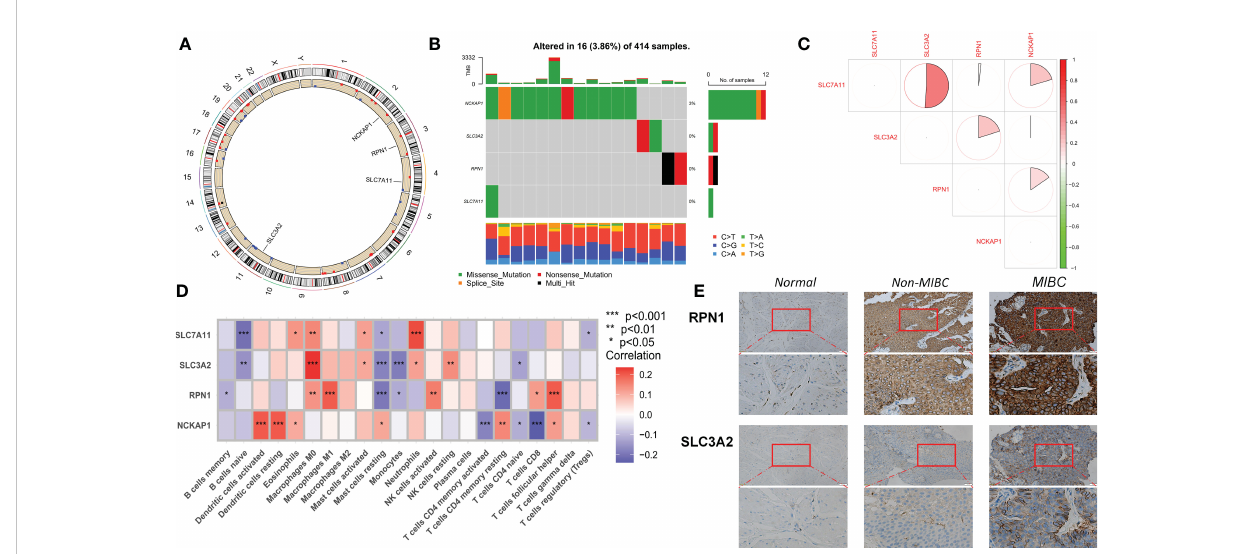
FIGURE 1 Transcriptional alterations and expression of DRG in BLCA. (A) Location of CNV alterations in DRG on chromosome 23. (B) Frequency of mutations in the 4 DRGs in 414 BLCA patients from the TCGA cohort. (C) Correlation of 4 DRG expressions. (D) Correlation of cibersort results showing expression of the 4 DRGs with immune cell in fi ltration. (E) IHC staining of SLC3A2 and RPN1 expression in normal tissue, Non-MIBC, and MIBC samples (at 20× magni fi cation, scale bar, 50 m m). MIBC Muscle invasive bladder cancer; *p<0.05; **p<0.01;